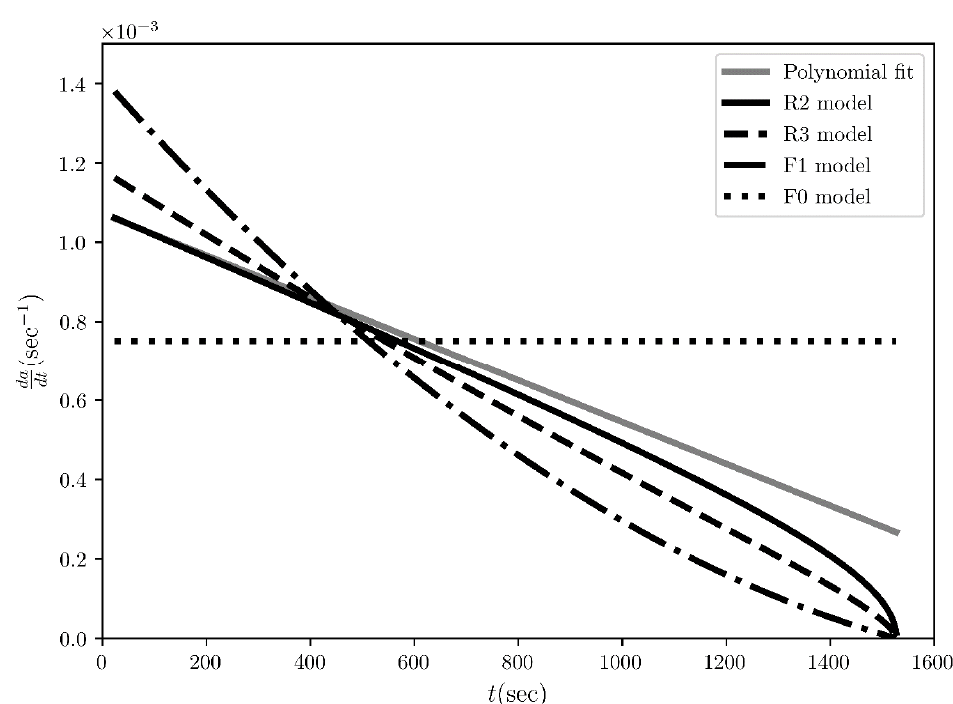
Figure 7. The reaction speed time evolution regarding the desolvation of the methanol solvates of ciclesonide at 115 °C. The solid grey line represents the rate evaluated from the initial polynomial that fits the experimental conversion fraction measured by L. Zhou et al. [3] while the solid and dashed black lines represent the fitting curves for the “best” four models ranked by COMF, i.e., R2, R3, F1 and F0 models. Table 3. The determination coefficients calculated at every step of the COMF method in the case of the desolvation of methanol solvates of ciclesonide at 115 °C.